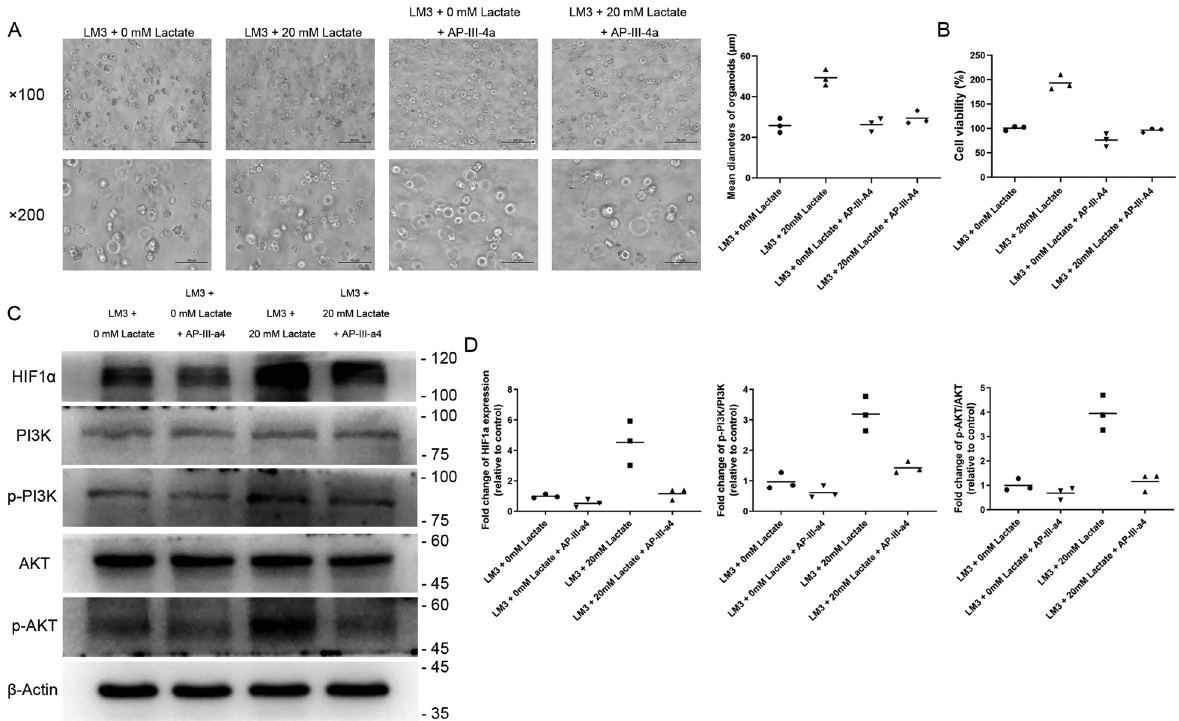
Fig. 2 Inhibition of ENO1 reversed the effect of lactate on the growth of LM3 organoids. A Bright- fi eld images of LM3 organoids treated with 20 mM lactate or AP-III-a4. Scale bars in ×100 row refer to 200 μ m and scale bars in ×200 row refer to 100 μ m. B Viability of LM3 organoids treated with 20 mM lactate or AP-III-a4. C Immunoblot showing bands corresponding to HIF1 α , PI3K, p-PI3K, AKT, p-AKT, and β -actin. D Quanti fi cation of the above proteins, p-PI3K/PI3K ratio, and p-AKT/AKT ratio in the indicated groups. * P <